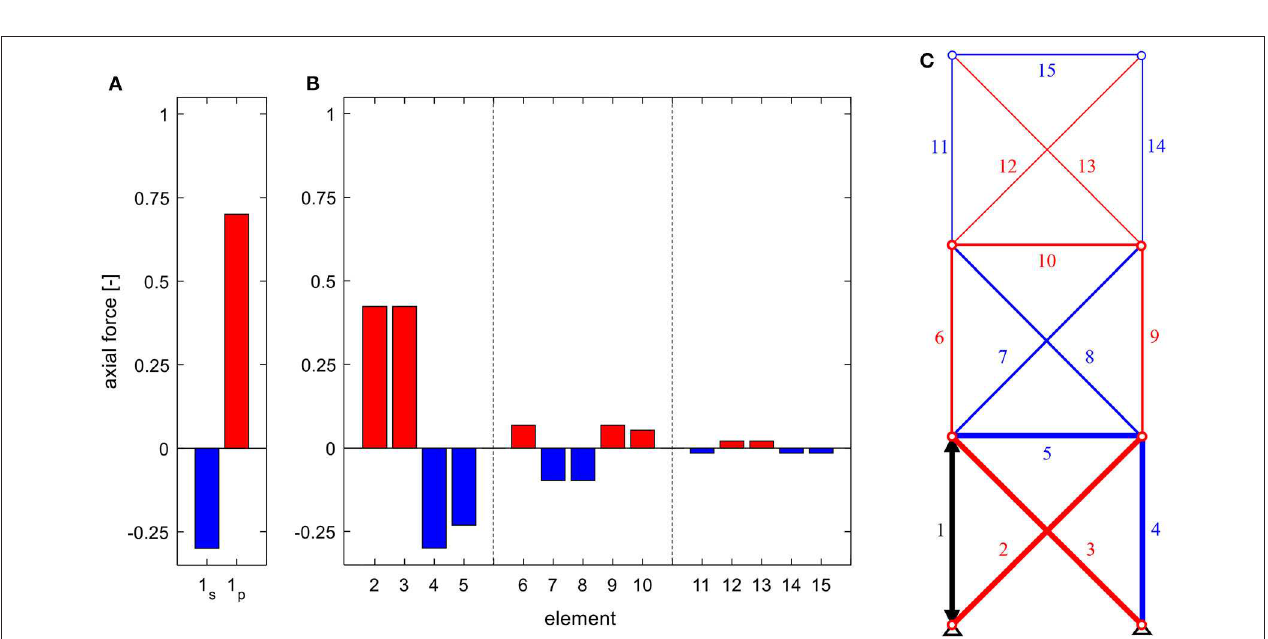
FIGURE 9 | Axial forces in (A) the actuated element for serial (index s ) and parallel (index p ) linear actuation, (B) the remaining structure due to the actuation of element 1 (C) , for a truss of the static degree of indeterminacy of n s = 3 and diagonals with increased stiffness.